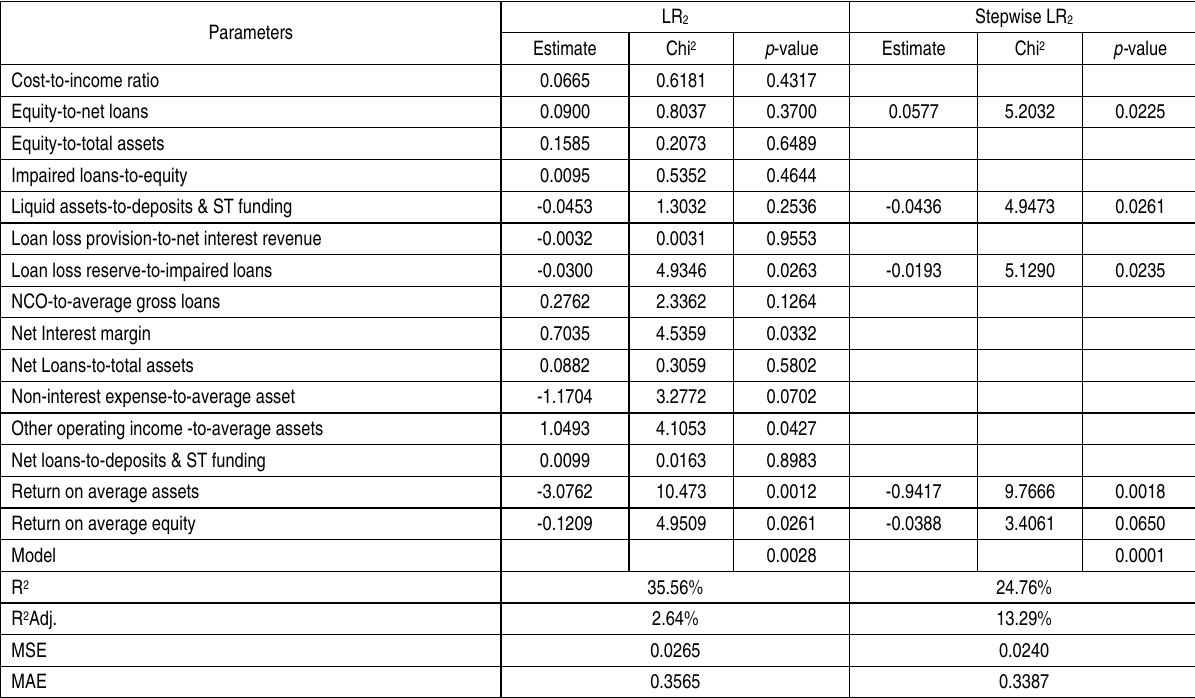
Table 4. Logistic regression analysis result for Model